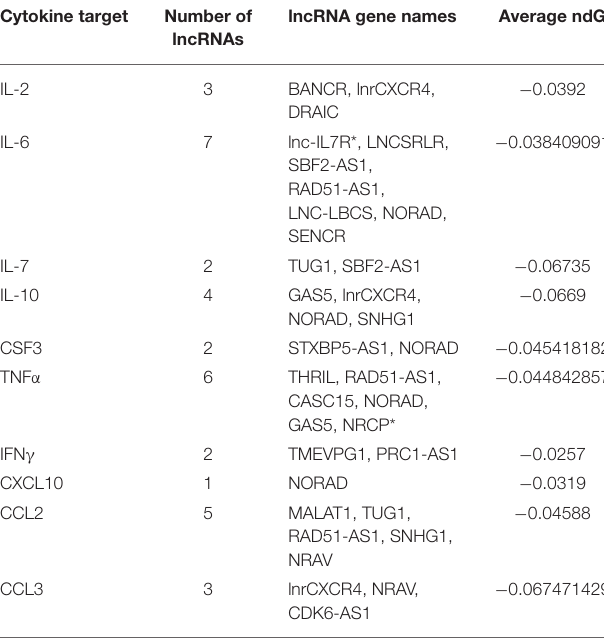
TABLE 2 | The most significant lncRNAs associated with COVID-19 cytokine storm cytokines, accompanied by lncRNA target prediction analysis using average ndG values.